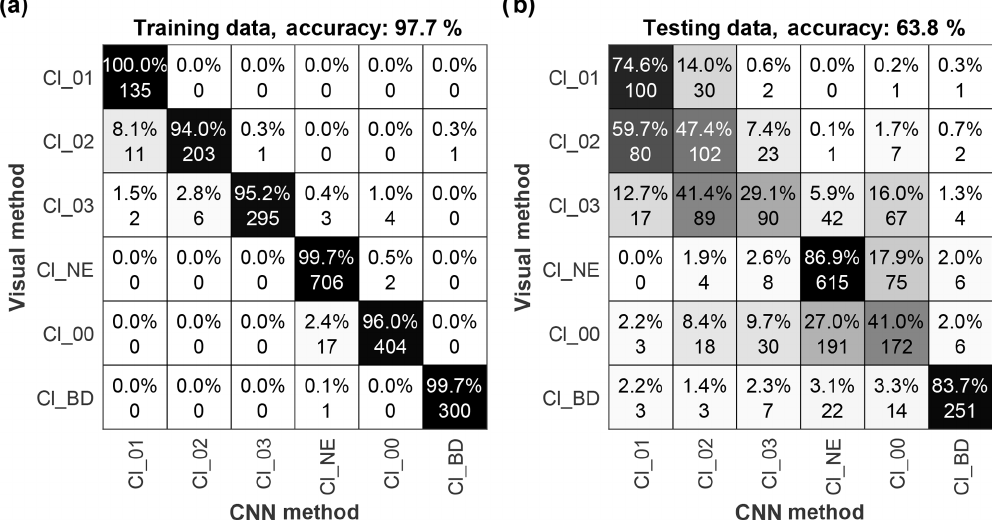
Figure 3. Confusion matrices of (a) training and (b) testing datasets from one run of Image Set 1 with a training–testing ratio of 50% / 50%. Numbers (percent and absolute number of days) in rows indicate how a certain class classified by a human (visually) were categorized in the CNN classification. Table 2. Summary of classification accuracy (%) of the transfer-learned CNN when applied for test datasets (mean value ± SD from 10 model simulations) for three image sets with three different percentages of training images. Some classes have been merged together: CL_01–02 is a combination of Class_01 and Class_02,